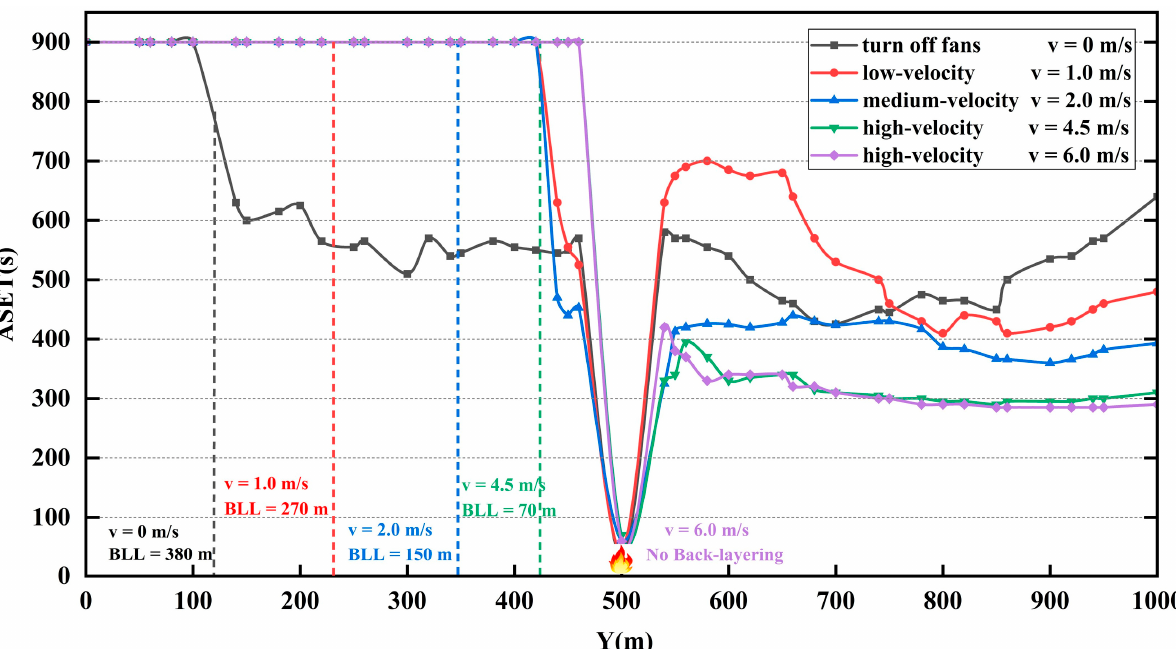
Figure 6. Distribution of ASET and back-layering length (BLL) at different longitudinal ventilation velocity (v).